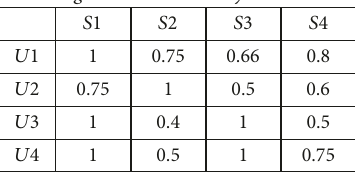
Figure 8: Similarity values.